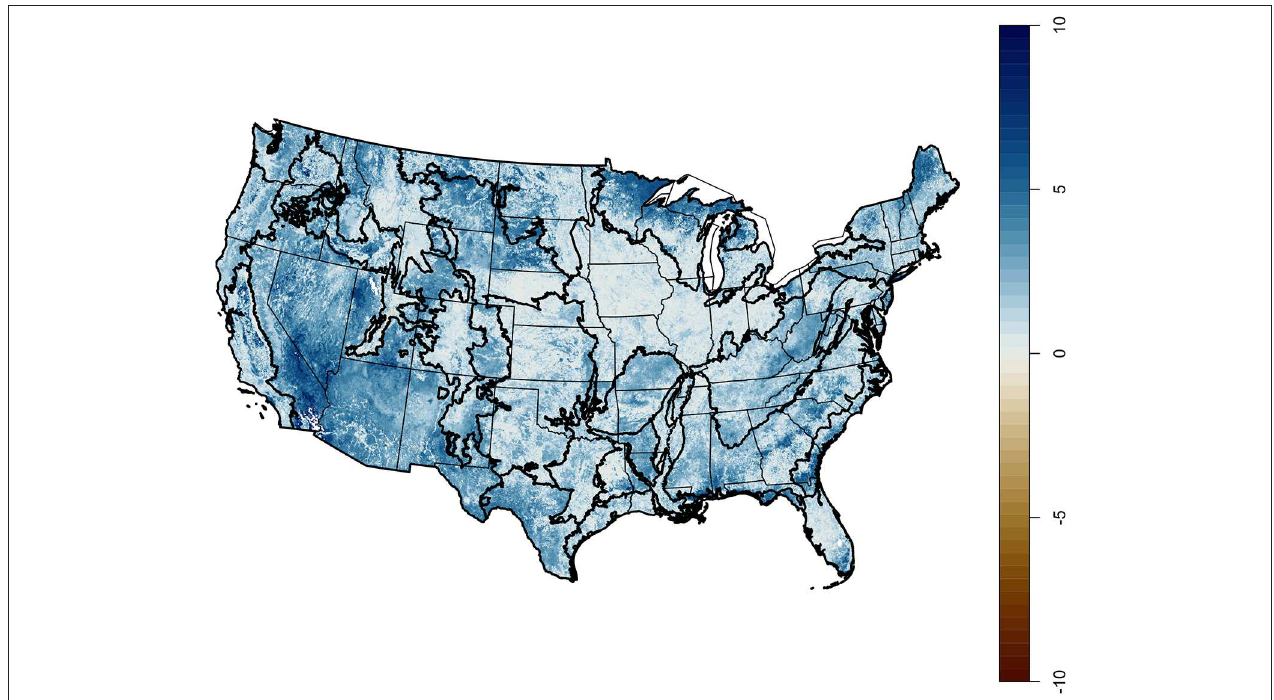
FIGURE 9 | The potential change in CER if the most diverse current system were applied across the contiguous US, given soils and